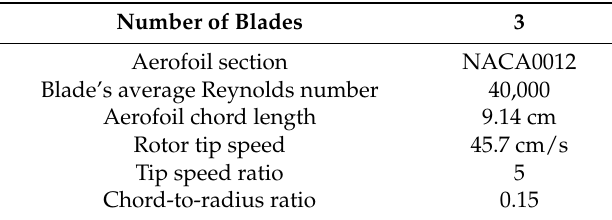
Table 2. Blade simulation characteristics.